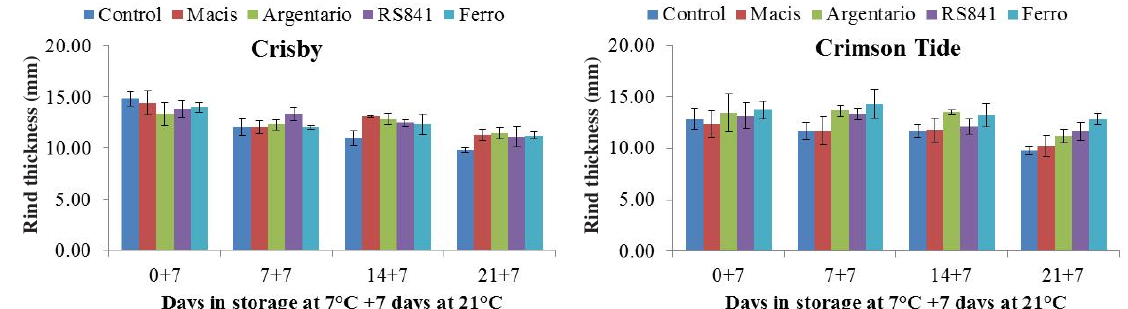
Fig. 1: Effects of rootstocks on rind thickness of ‘Crisby’ and ‘Crimson Tide’ watermelon fruits after shelf life period for 7 days at 21 °C following storage at 7